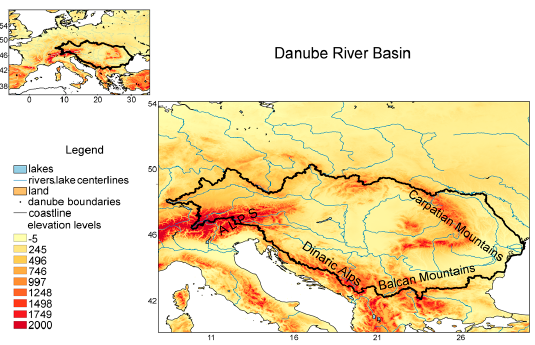
Figure 1. Black line indicates the boundaries of the Danube River Basin. Colours represent elevation levels in metres.